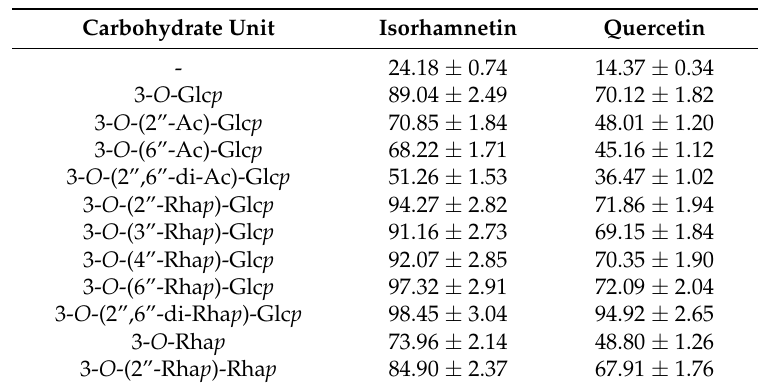
Table 3. Anti-acetylcholinesterase activity of isorhamnetin, quercetin and its glycosides (IC 50 , µ M ± SD) 1